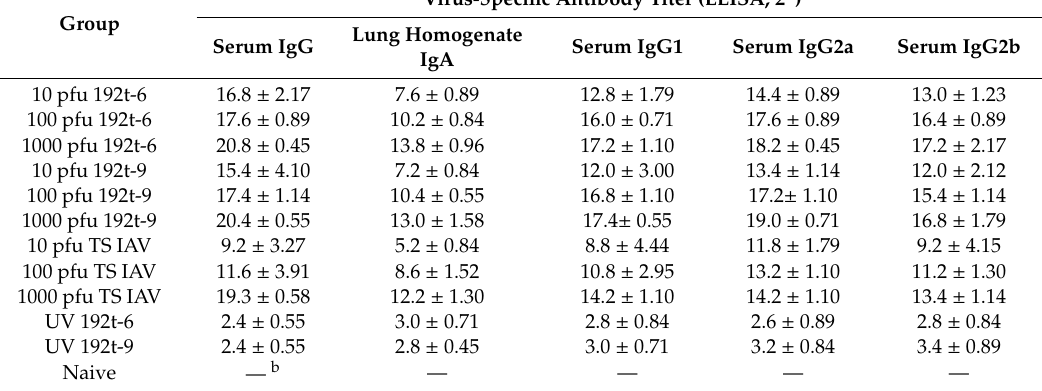
Table 2. Serum and mucosal antibody responses in mice by intranasal administration of 192t-6 or 192t-9 or TS IAV